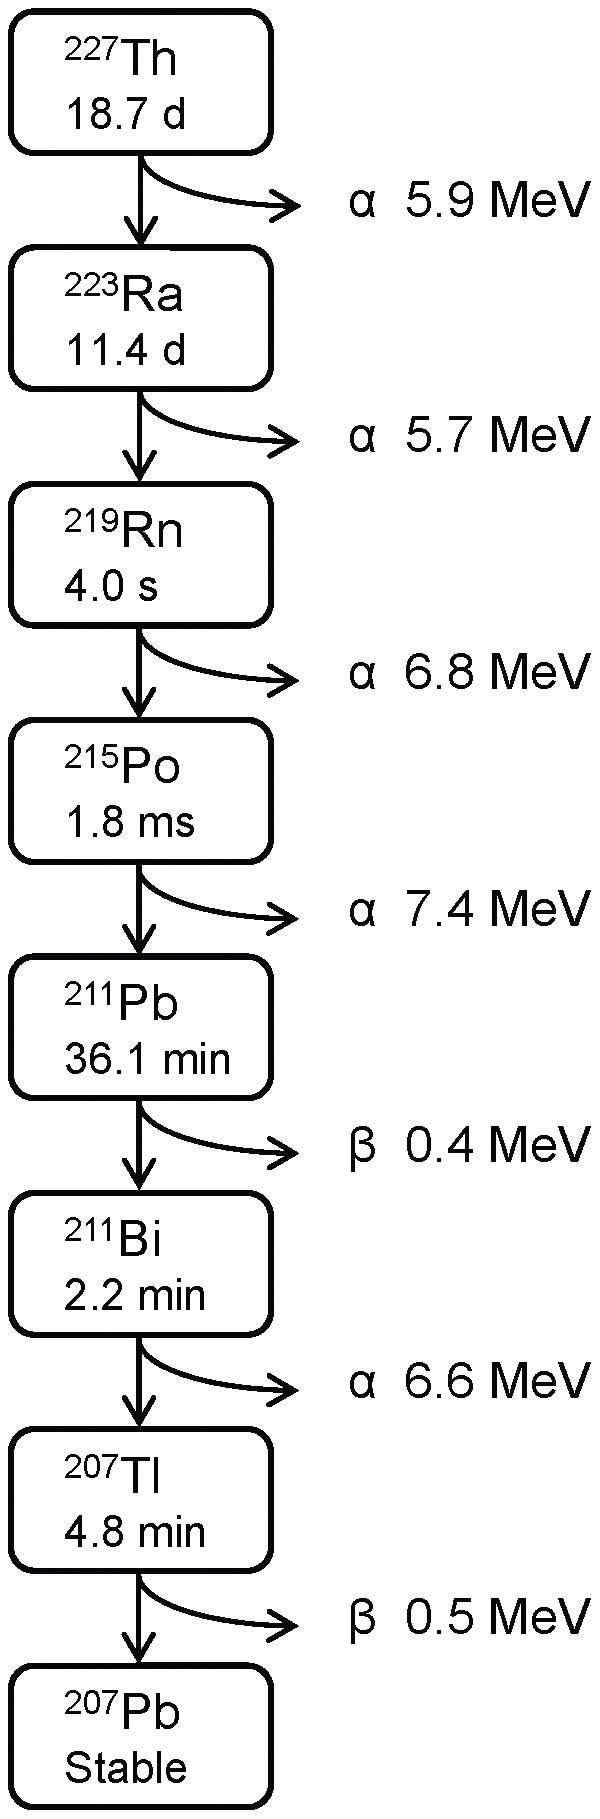
Th-227 decay scheme.